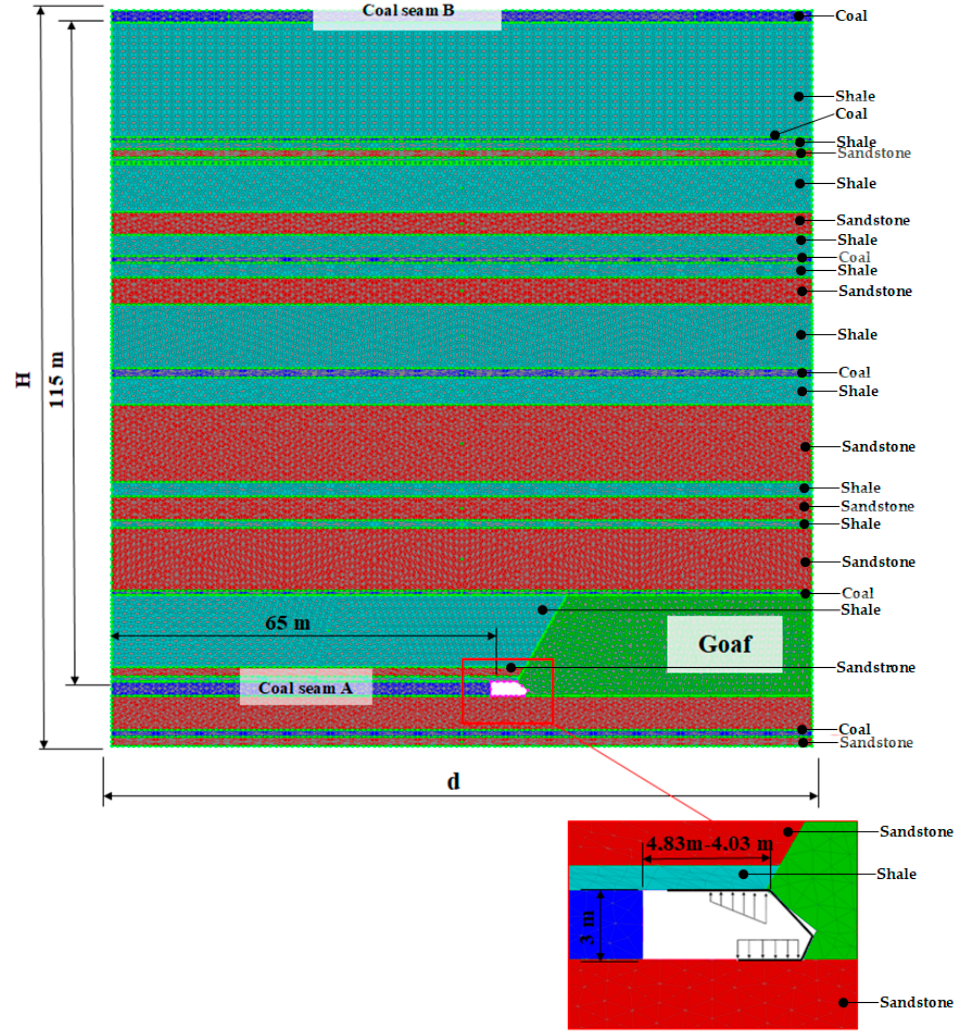
Figure 4. Numerical grid of the cross-section of the analyzed rock mass for variant I.